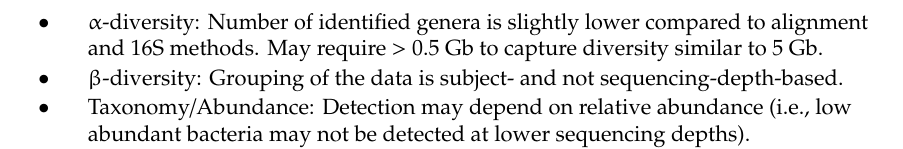
Table 2. Summary of shotgun metagenomic sequencing results at various sequencing depths and annotation with marker gene mapping (MetaPhlAn2) and alignment (BURST) at genus and species levels. Genus level results were compared to 16S information. Table also shows summary of pathway information annotated using UniProt and MetaCyc, as well as virome information at various sequencing